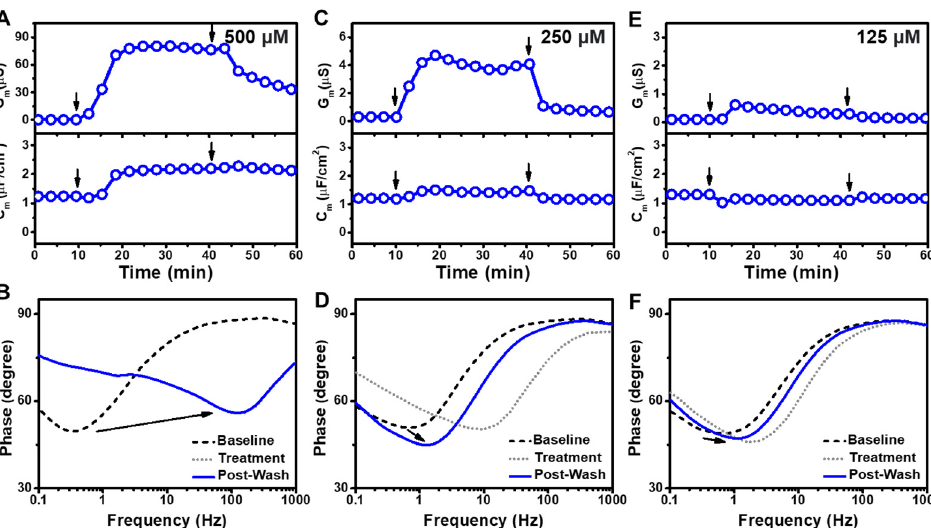
Figure 2. ( A ) Time-resolved conductance (G m ) and capacitance (C m ) shifts upon 500 µM GML addi- tion to the tBLM platform. The arrows indicate compound addition at t = 10 min and buffer washing at t = 40 min, respectively. ( B ) Bode plots for 500 µM GML addition to the tBLM platform, whereby baseline, treatment, and post-washing reflect the initial measurement signal, signal after compound addition, and signal after buffer washing, respectively. Corresponding data for ( C , D ) 250 µM GML and ( E , F ) 125 µM GML addition to the tBLM platform.